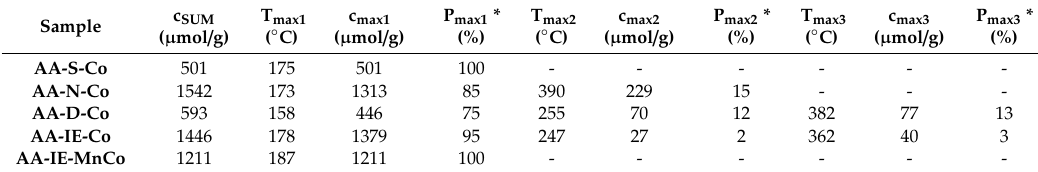
Figure 5. Acidity ( a ) and basicity ( b ) of cobalt catalysts determined by NH 3 -TPD and CO 2 -TPD, respectively. Table 2. Acidity of cobalt catalysts determined by ammonia